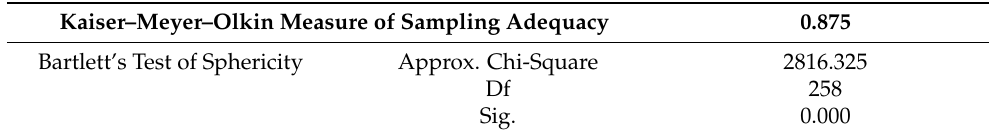
Table 3. Research results using KMO and Bartlett’s